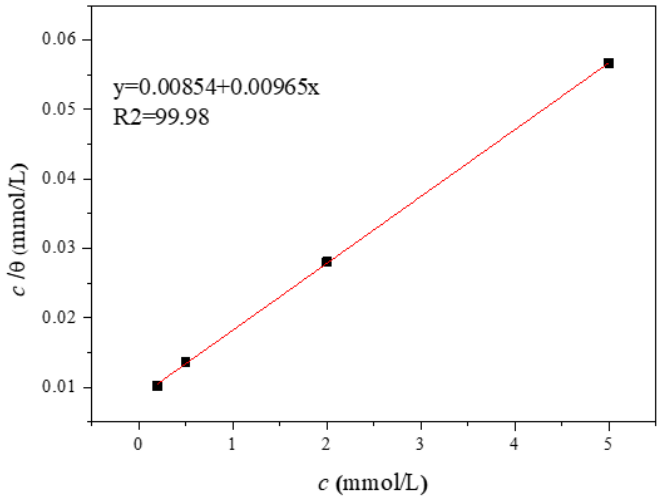
Figure 3. Adsorption isotherm of inhibitor on Q235 carbon steel surface in simulated concrete solution with 3.5% NaCl and different inhibitor concentrations.